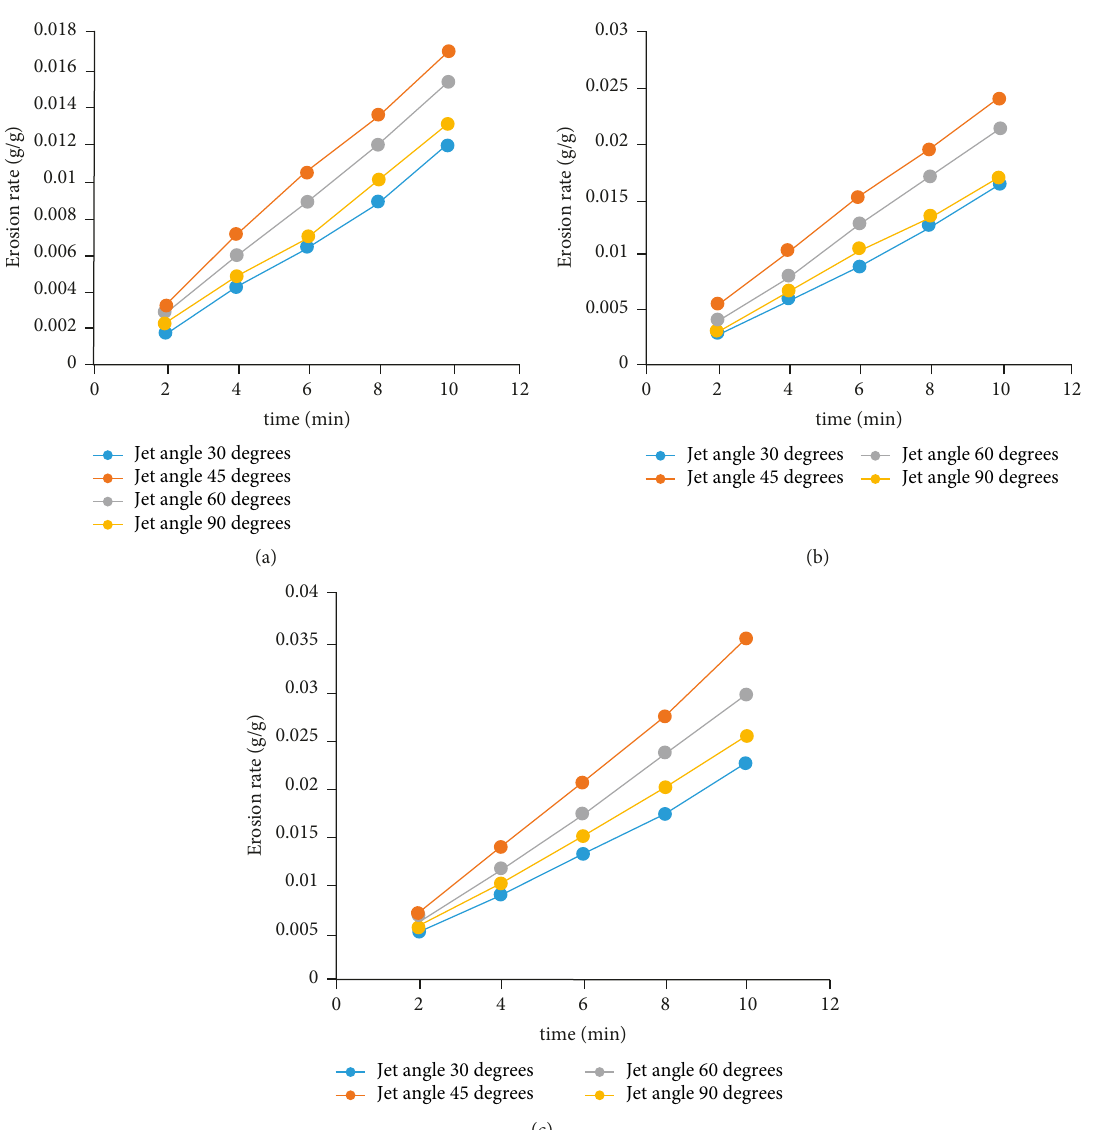
Figure 9: 5 layers glass fibre. (a) 1 bar pressure and 7.5% nanocarbon powder filler. (b) 1.5 bar pressure and 7.5% nanocarbon powder filler. (c) 2 bar pressure and 7.5% nanocarbon powder